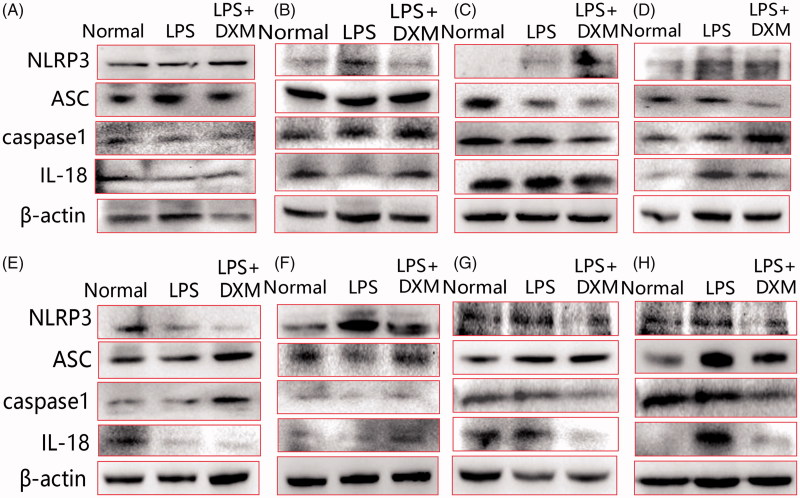
Images of protein expression of the NLRP3 signalling pathway in the major organs of mice after intravenous administration of LPS. Western blot assays were employed. (A) Heart; (B) liver; (C) spleen; (D) lung; (E) kidney; (F) brain; (G) small intestine; (H) large intestine. DXM: Dexamethasone.